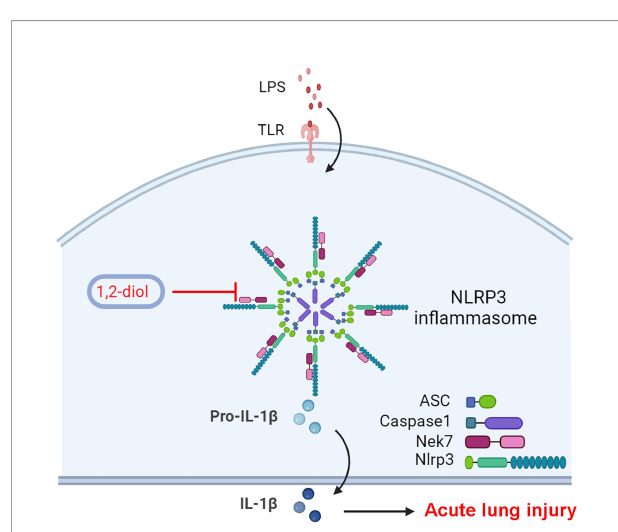
FIGURE 6 | Schematic diagram of suppressive role of 1,2-diol on NLRP3 in fl